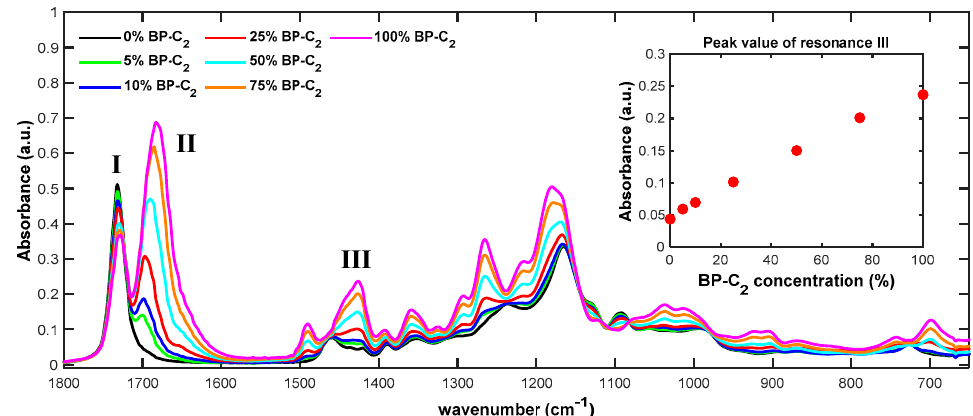
Figure 2. Overlay of attenuated total reflection Fourier transform infrared (ATR-FTIR) spectra (between 1800 and 650 cm − 1 ) of the polymers synthesized in this study. Note, the spectra were collected at 100 °C.